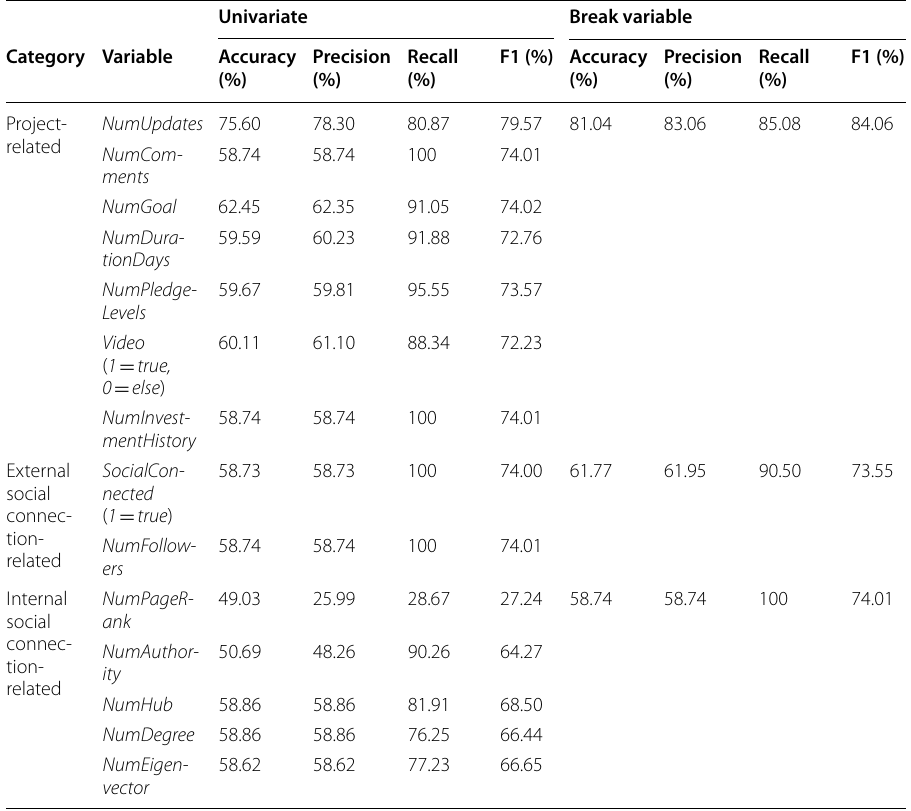
Table 10 Predictive power of measures using SVM Univariate Break variable Category Variable Accuracy Precision (%)